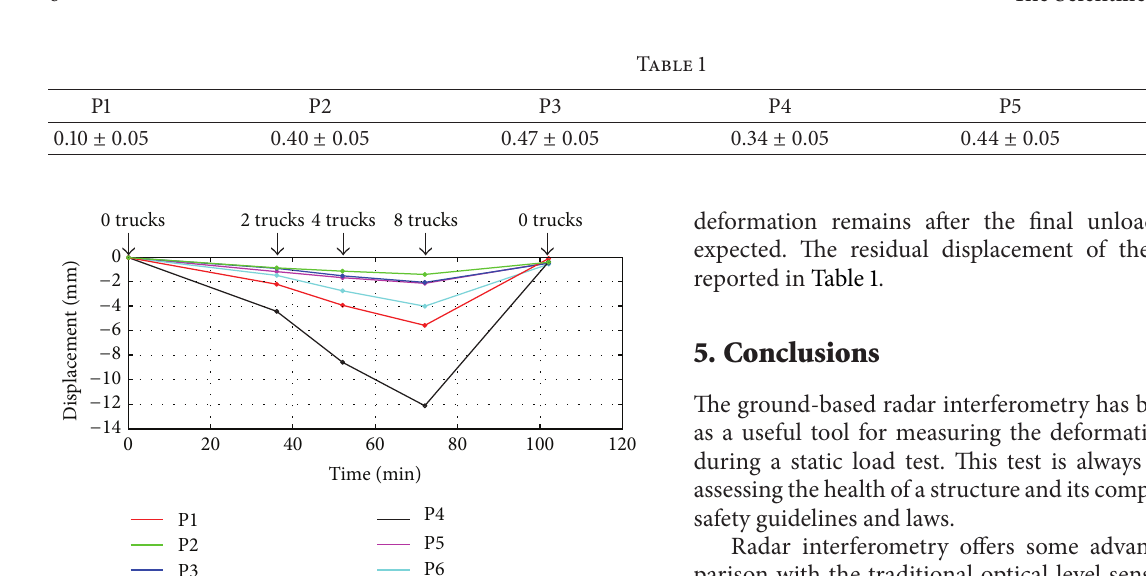
the 𝑋 axis is the cross-range. The targets highlighted with red circles refer to the corner reflectors and other structural characteristics of the